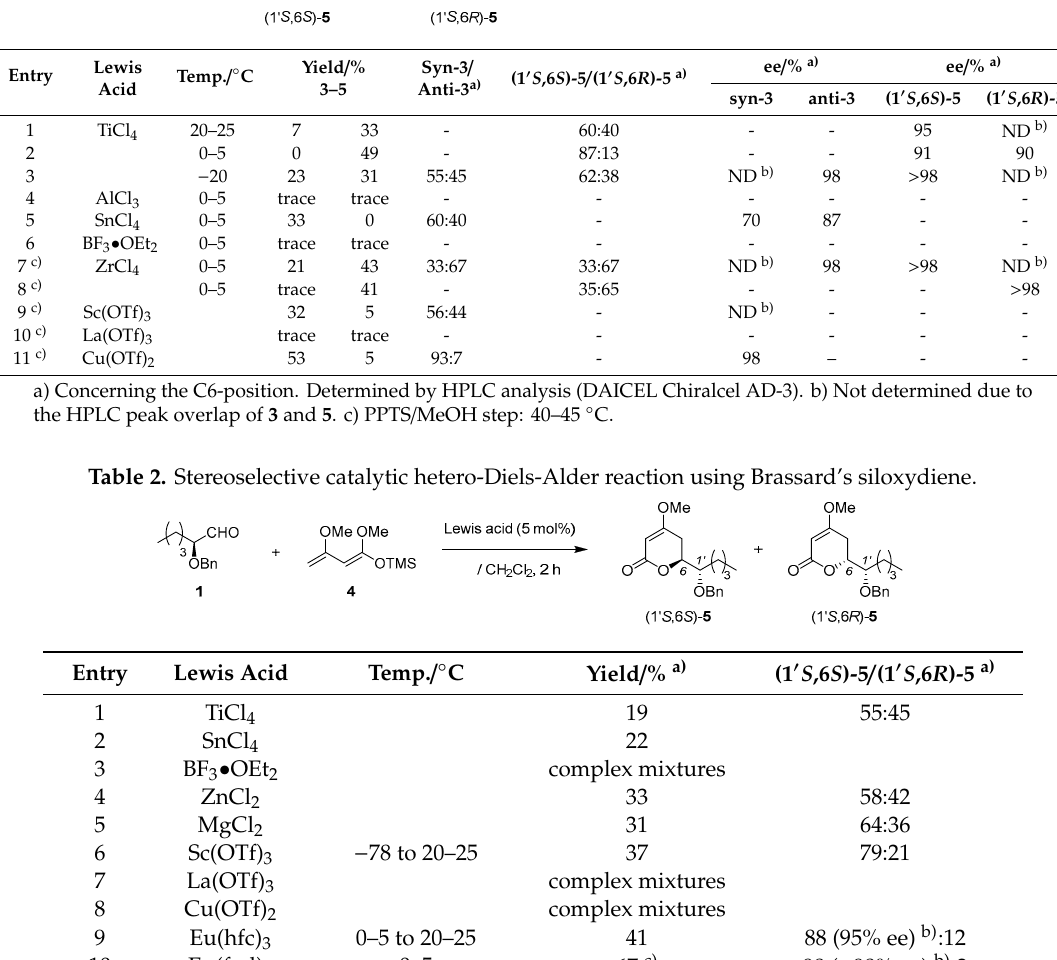
Molecules 2020 , 25 , x FOR PEER REVIEW 6 of 15